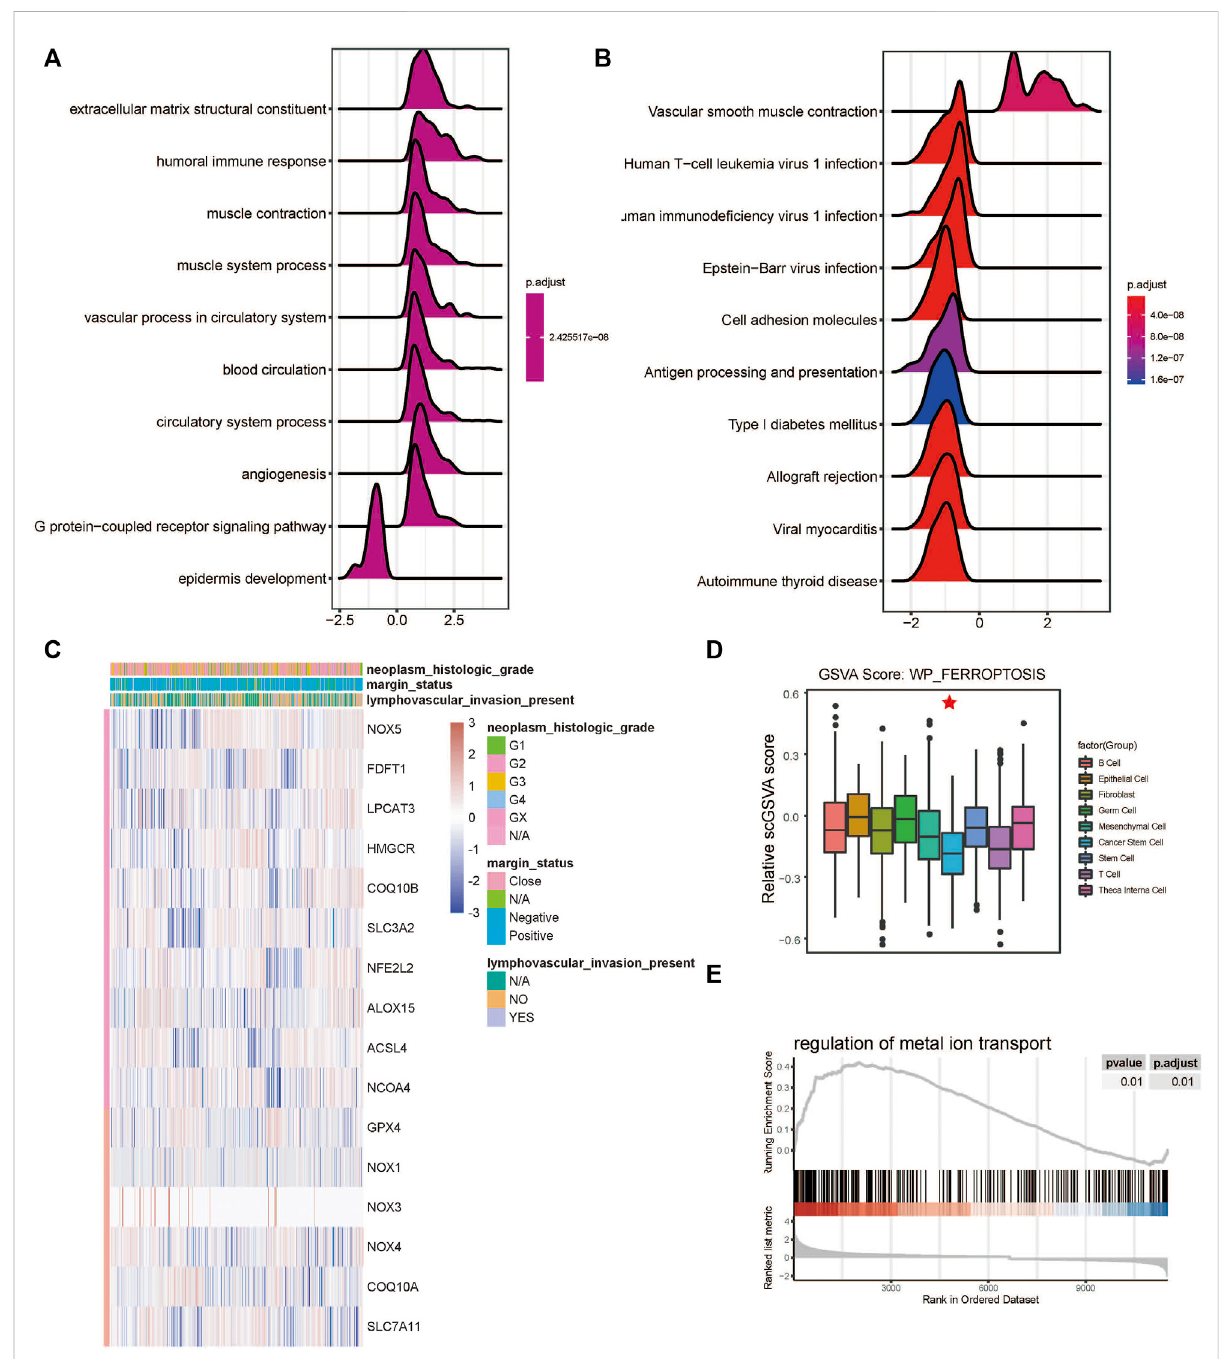
FIGURE 3 Ferroptosis-related cellcluster andpathway analysisinHNSCC. (A) GOand (B) KEGGpathway enrichmentanalyses ofdifferentialgeneclusters from the scRNA dataset: the abscissa represents the normalized enrichment score, and the adjusted p -value is represented by the colored areas of the graph. (C) Unsupervised clustering of expression level of genes of WP-FERROPTOSIS pathway. (D) Distribution of WP-FERROPTOSIS score in HNSCC cell clusters. (E) Signi fi cant enrichment of regulation of the metal ion transport pathway in the differentially expressed genes of the cancer stem cell